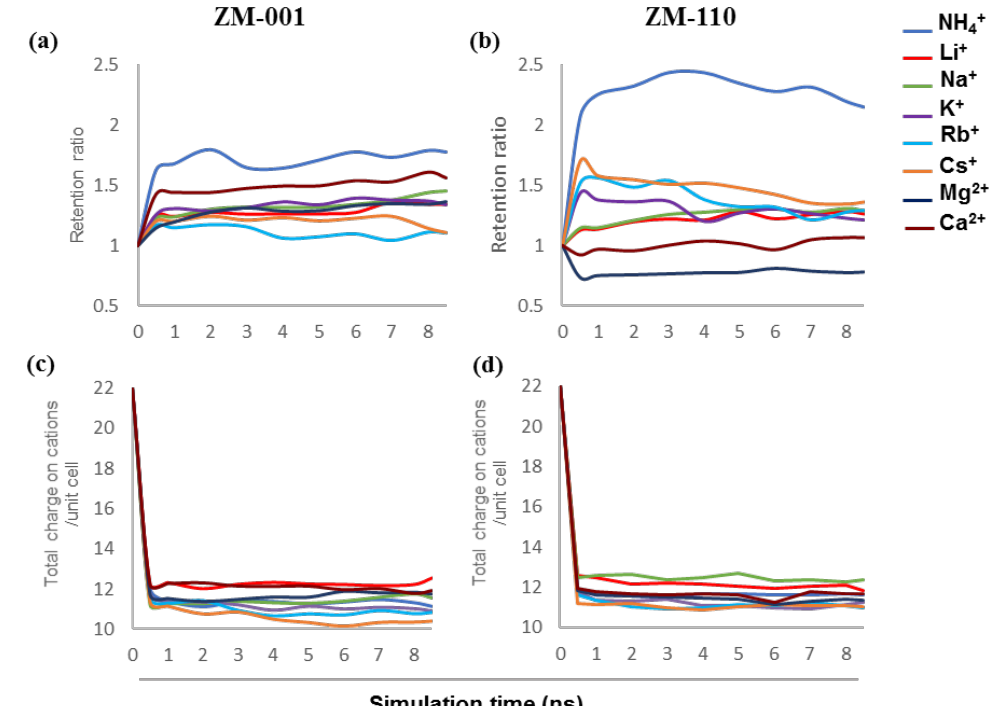
Figure 1. The retention ratio of guest to host ions in ( a ) ZM-001 and ( b ) ZM-110, and the total charge on cations per unit cell of ( c ) ZM-001 and ( d ) ZM-110.